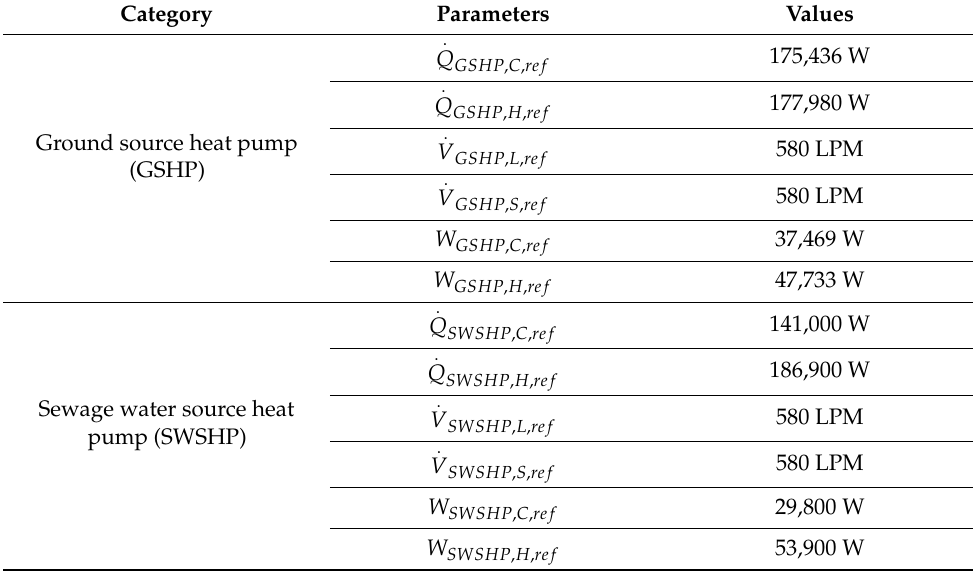
Table 3. Reference conditions of the heat pumps provided by the